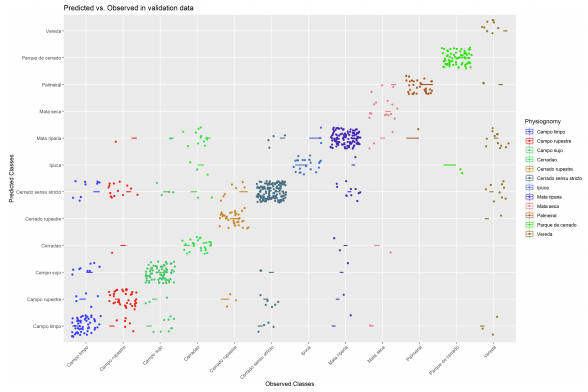
Figure 3. Confusion matrix for the classification model of Level-1.